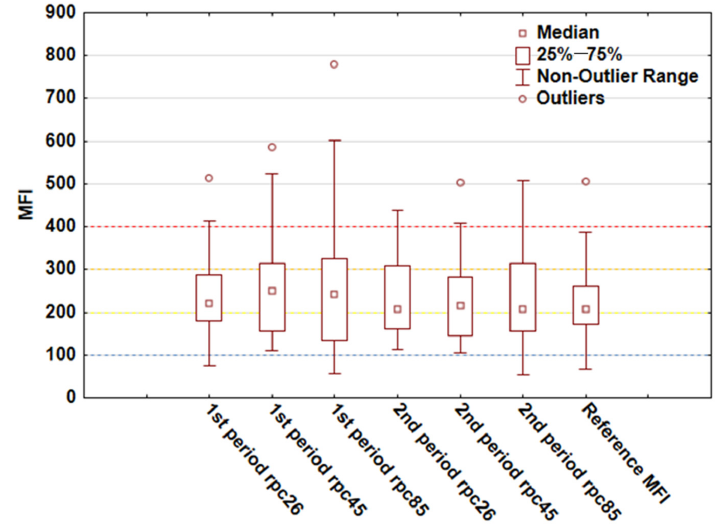
Figure 15. Variance in the distribution of velocity values for the reference period and the climate scenarios. Dashed lines are reference lines indicating the MFI class boundaries as stated in Equation (1).